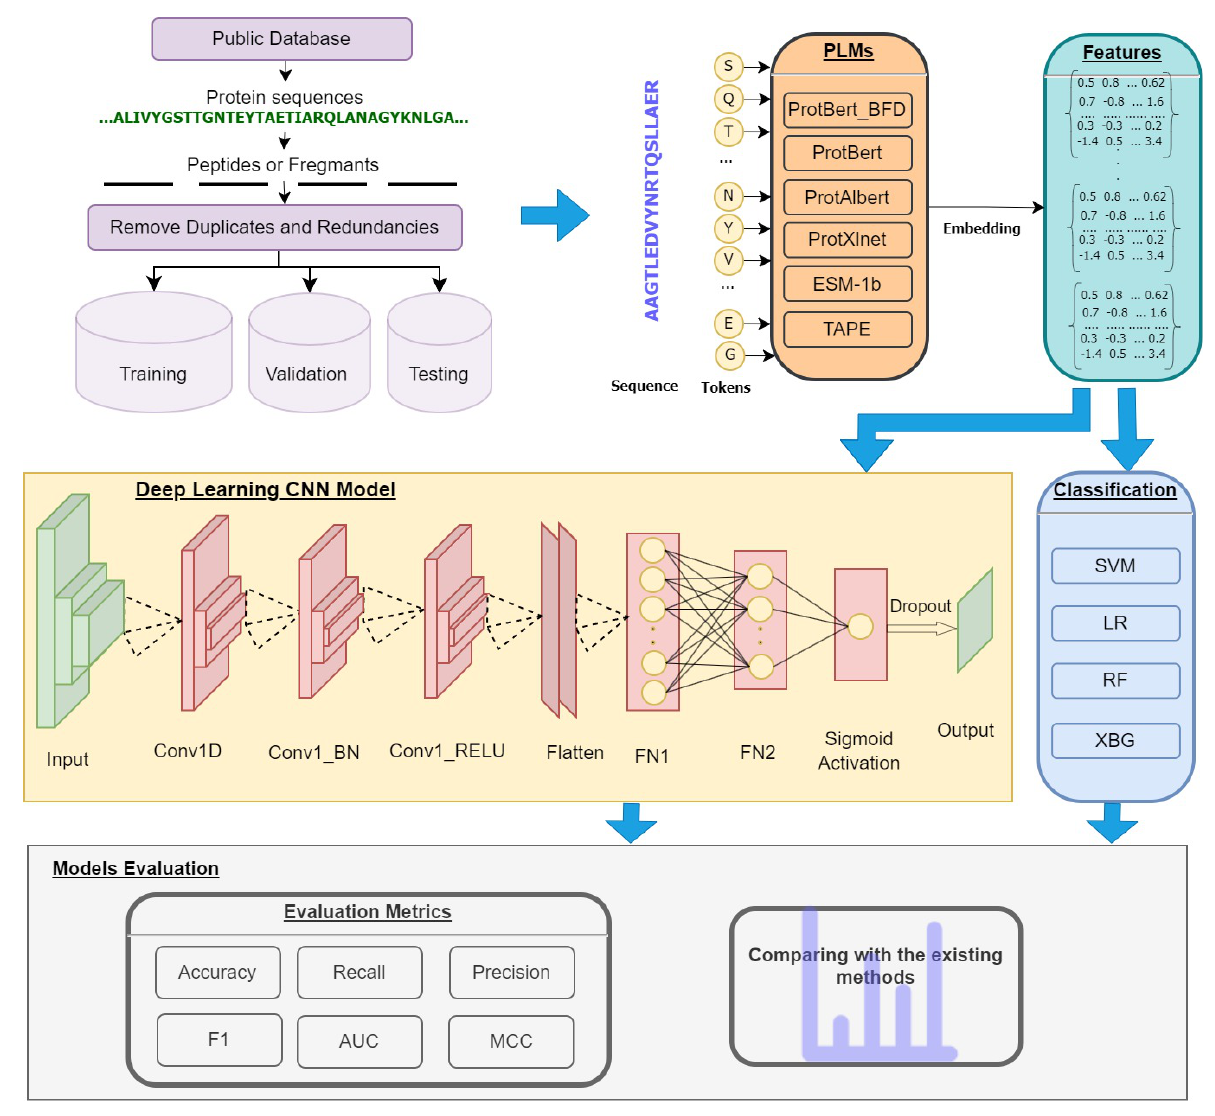
Figure 1. The general flowchart of